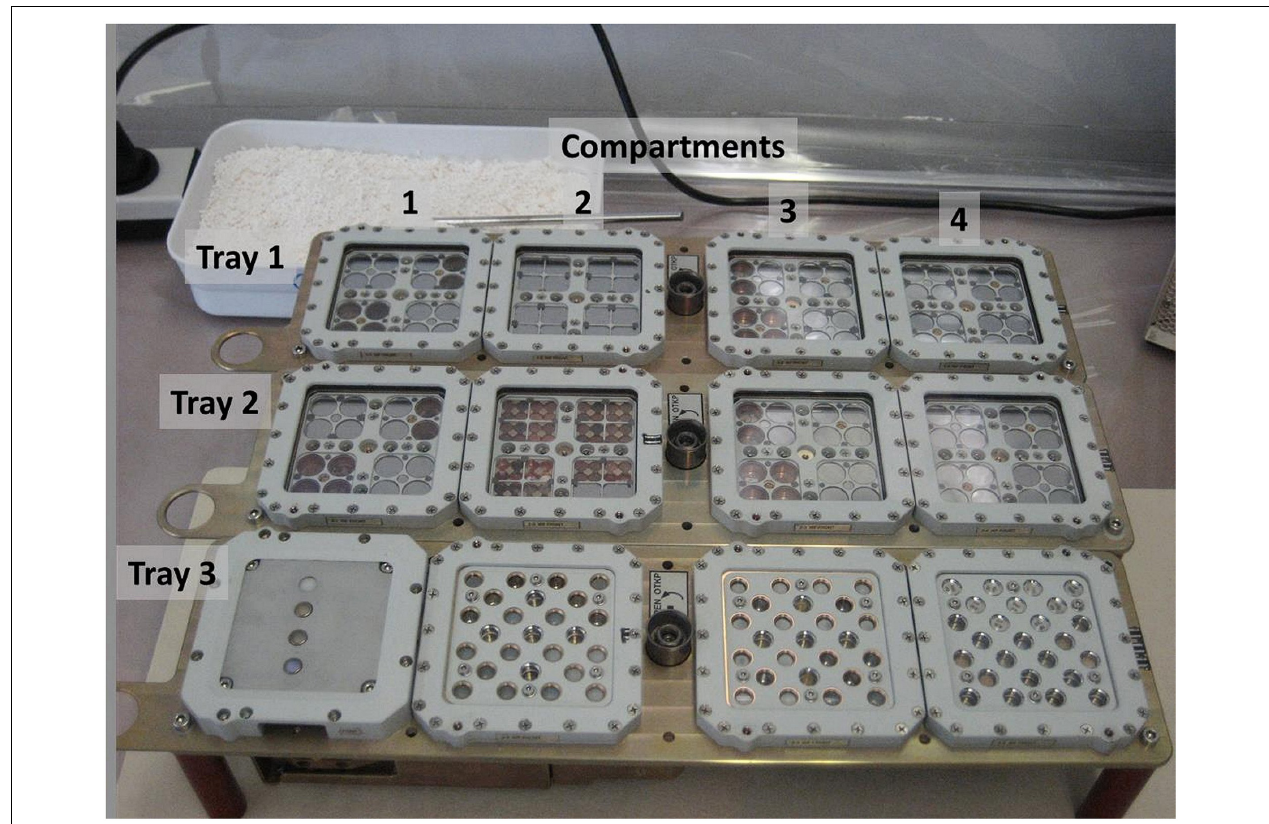
FIGURE 1 | EXPOSE-R2 flight trays with all experiments integrated. Top to bottom: Trays 1, 2, 3; left to right: compartments 1, 2, 3, and 4. Valves and earrings are on the left side. Bottom left compartment with the active radiation measurement instrument R3D. The earrings were intended to secure the trays during EVAs. Credit: